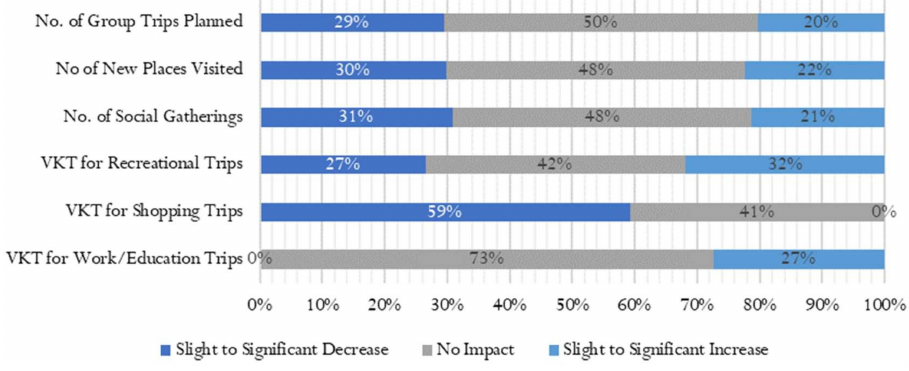
Figure 3. Outcome-wise, the share of responses on the impacts of smartphone apps.